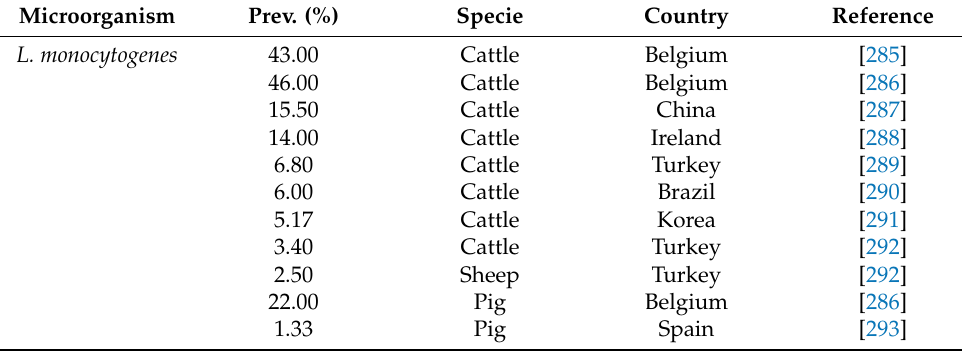
Table 10. Prevalence of L. monocytogenes and S. aureus in